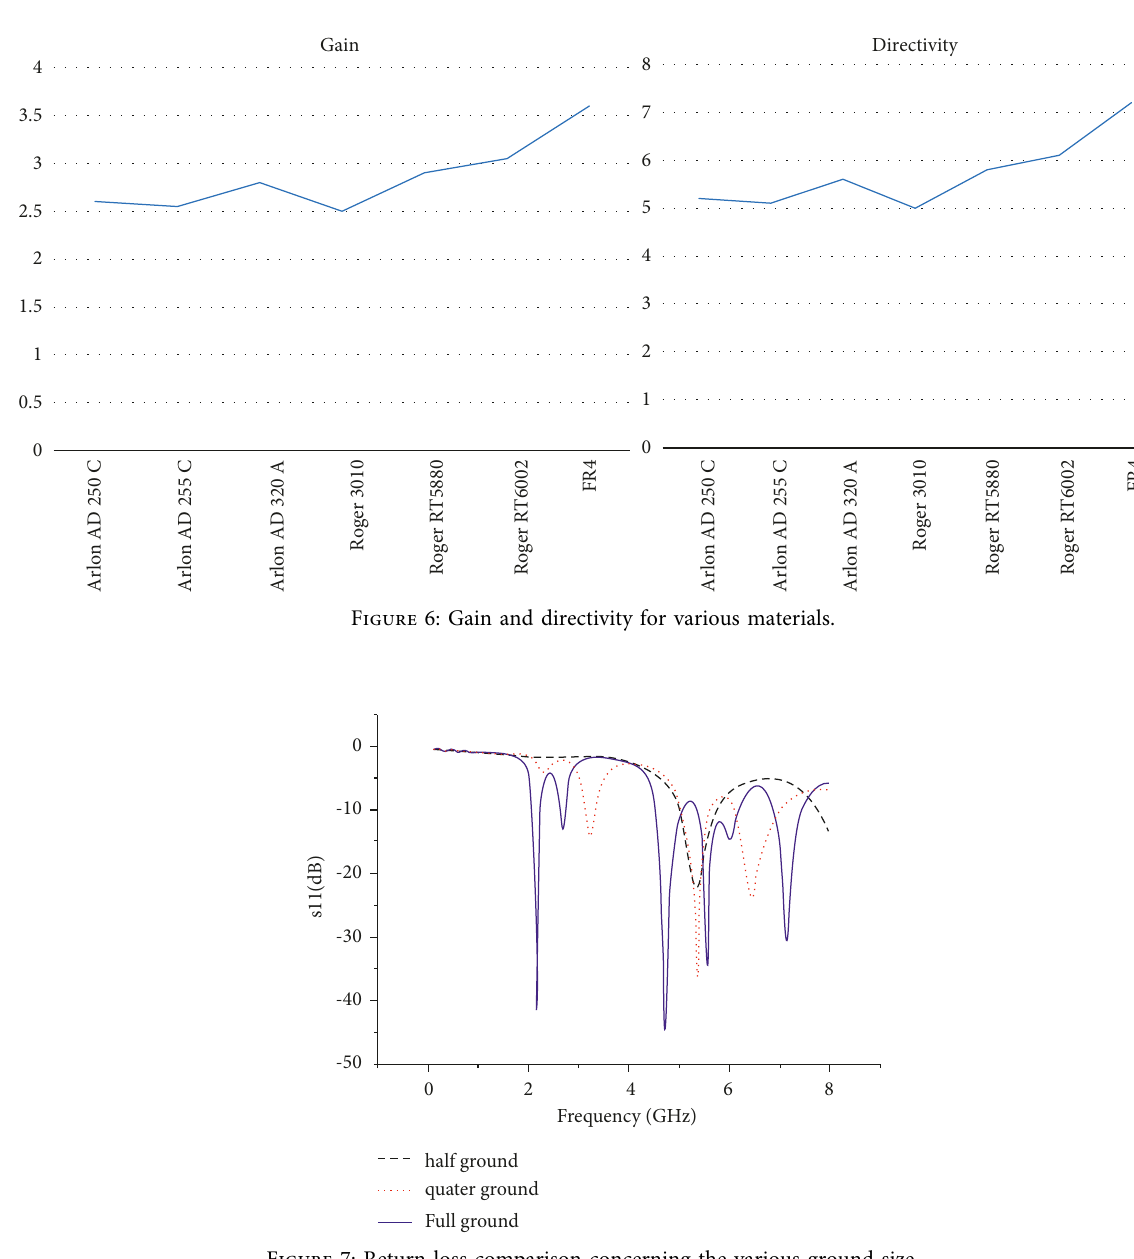
Figure 7: Return loss comparison concerning the various ground